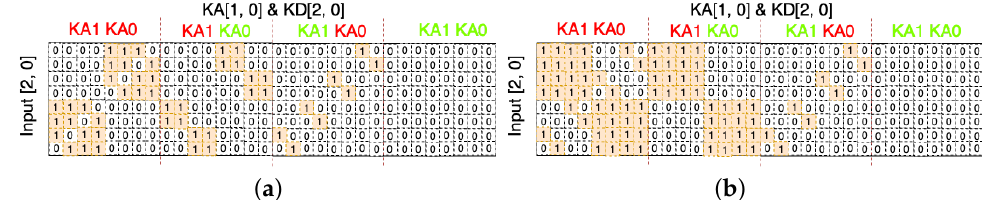
Figure 9. The truth tables representing corruption (1 in light orange) with the proposed improved SWC structure, depending on the possible key values (correct bits in green and incorrect bits in red): ( a ) one SKG connected to sw 2 and one SKG connected to sw 1 , ( b ) one SKG connected to sw 2 and one SKG connected to sw 0